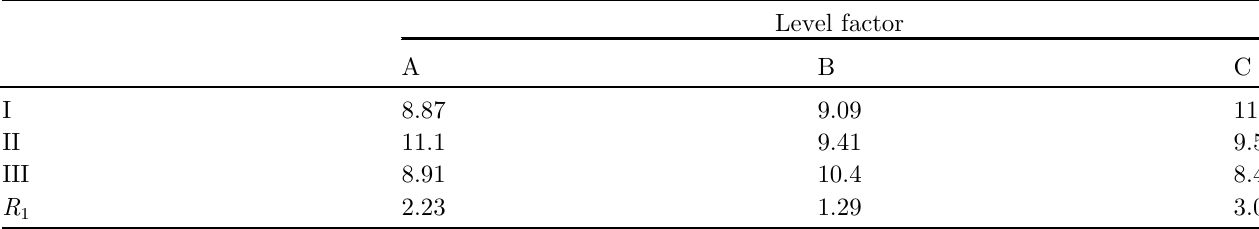
range analysis. 1